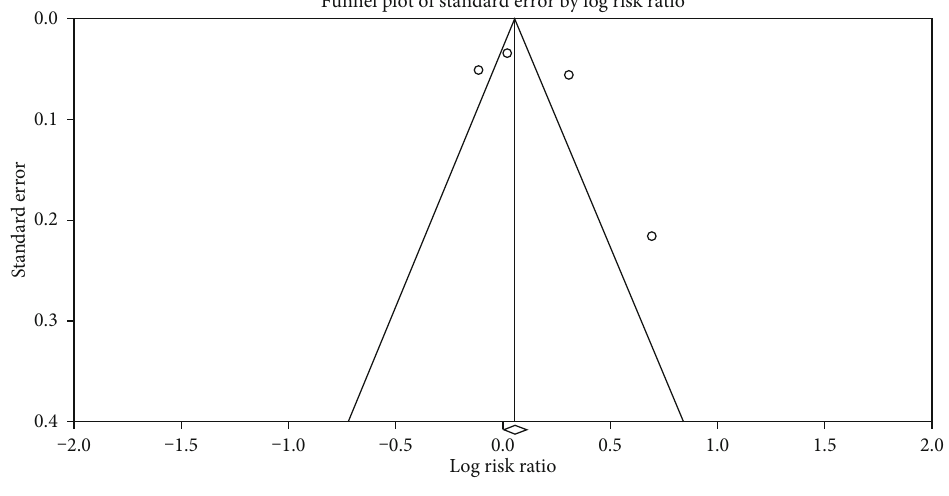
Figure 4: Funnel